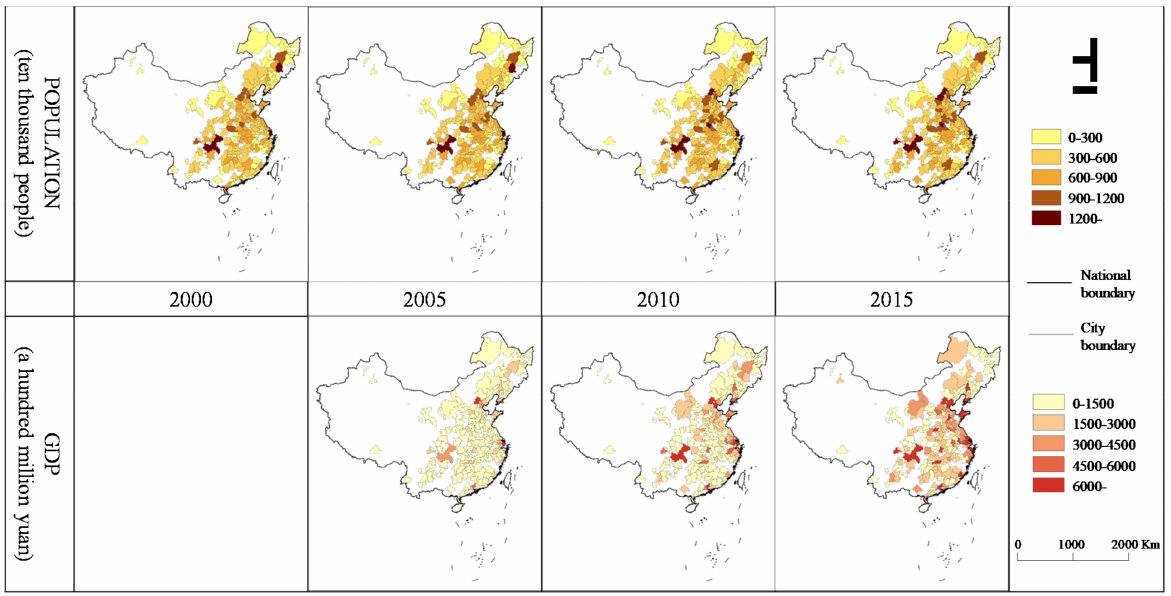
Figure 4. Spatial distribution of the GDP and population at the city